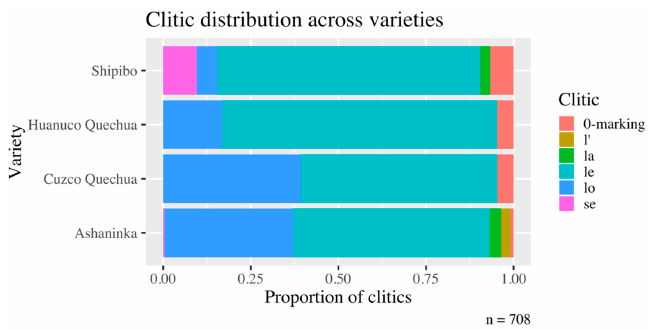
Figure 10. Distribution of clitics across varieties of bilingual Spanish. The following examples illustrate the preferences for clitics in clitic doubling structures and anaphoric clitic structures: 19